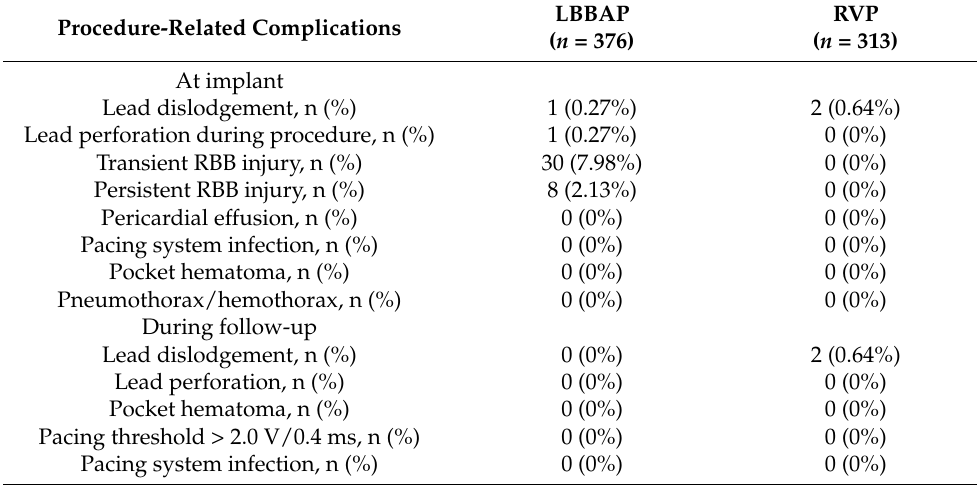
Table 4. Procedure-related complications at implant and during